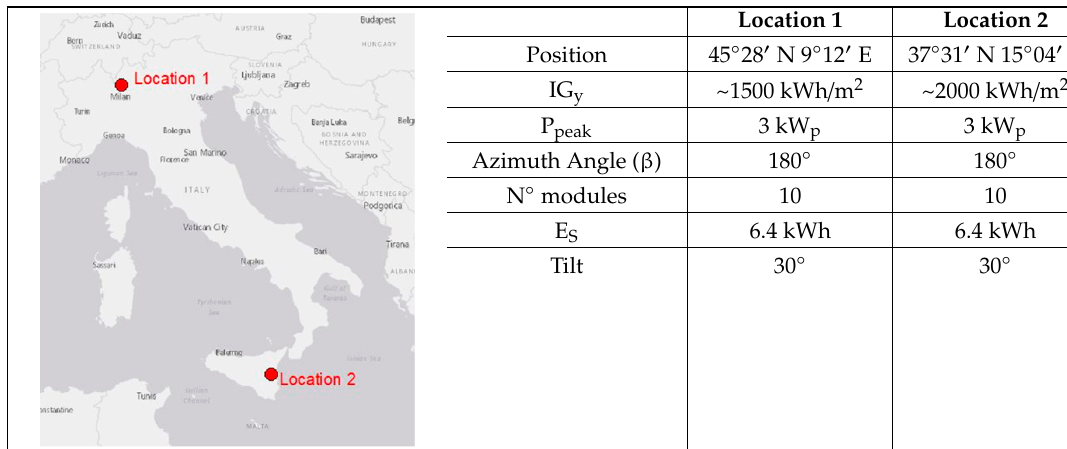
Table 4. The geographical cases of study.